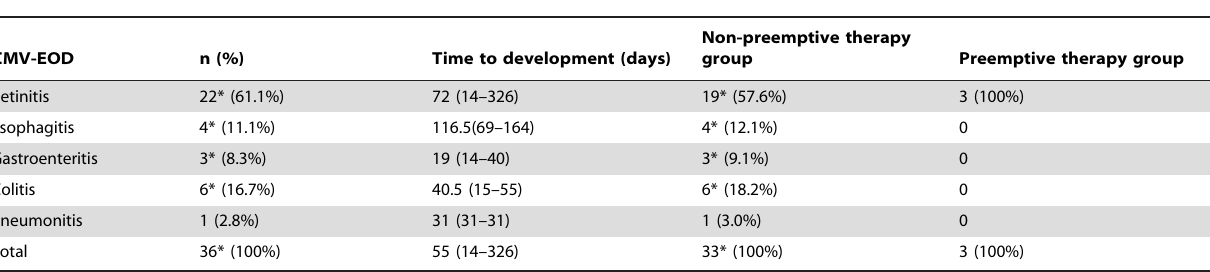
Table 4. Details of CMV end-organ